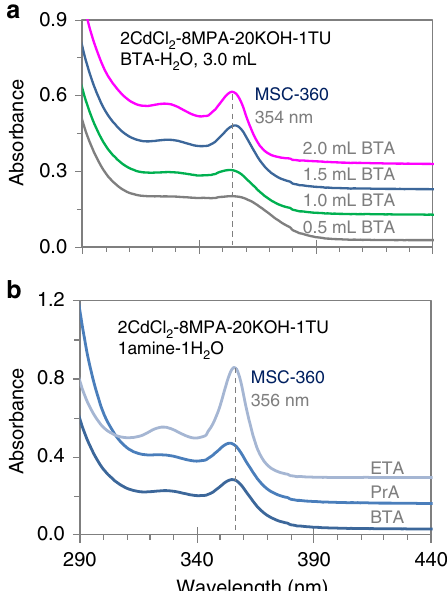
Fig. 2 Absorption spectra (offset) of the same mixture in different solvents. a The four solvents are 3.0mL of BTA and water mixtures, with 0.5 (gray trace), 1.0 (green trace), 1.5 (blue trace), and 2.0 (magenta trace) mL BTA. b The three solvents are the mixtures of 1.5mL primary amines (BTA (blue trace), PrA (lighter blue trace), and ETA (lightest blue trace)) and 1.5mL water. All the spectra are collected from the solutions kept in cuvettes at room temperature for 24h. The dashed lines signify the positions indicated. Evidently, increasing the amount of BTA, or using a primary amine with a shorter alkyl chain, facilitates the production of MSC-360.